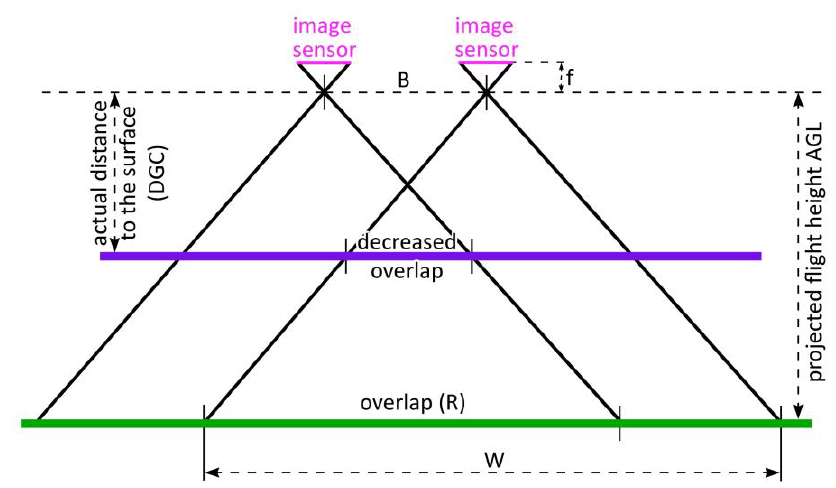
Figure 4. Decreased overlap in steep terrain. Figure 4 . Decreased overlap in steep terrain.